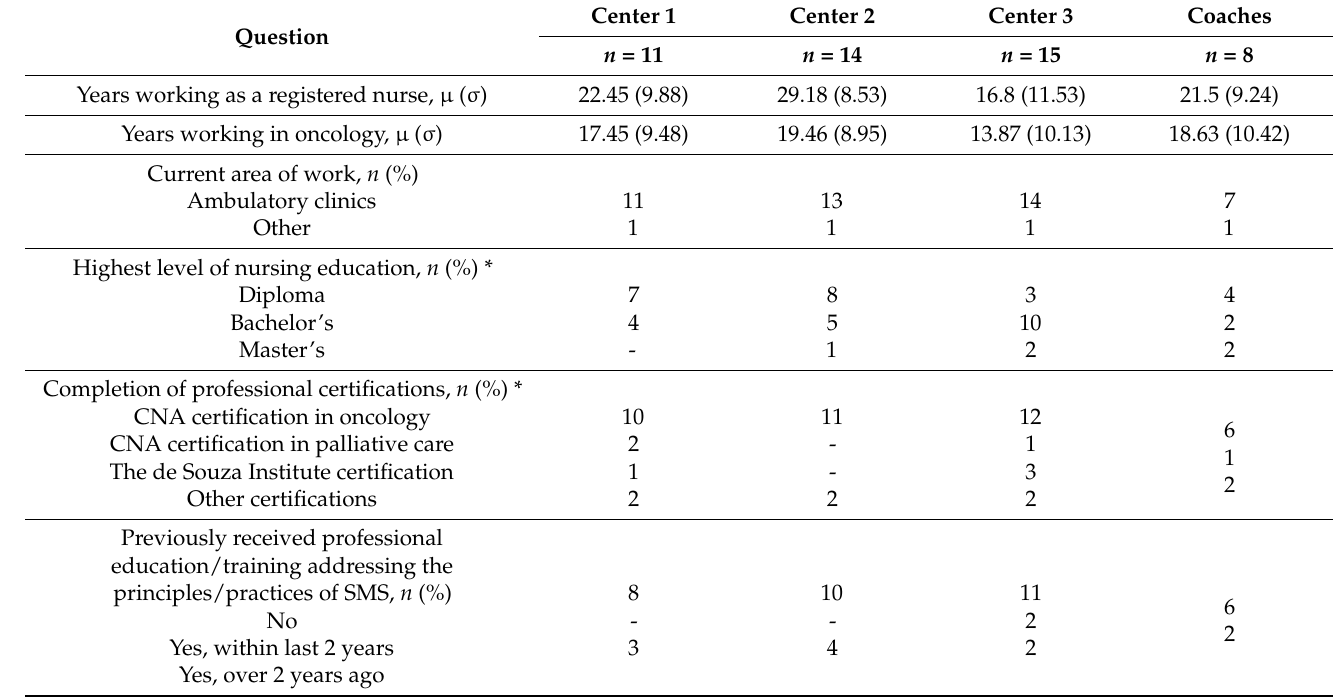
Table 1. Baseline demographics of ambulatory clinic staff nurses by center and for coaches.